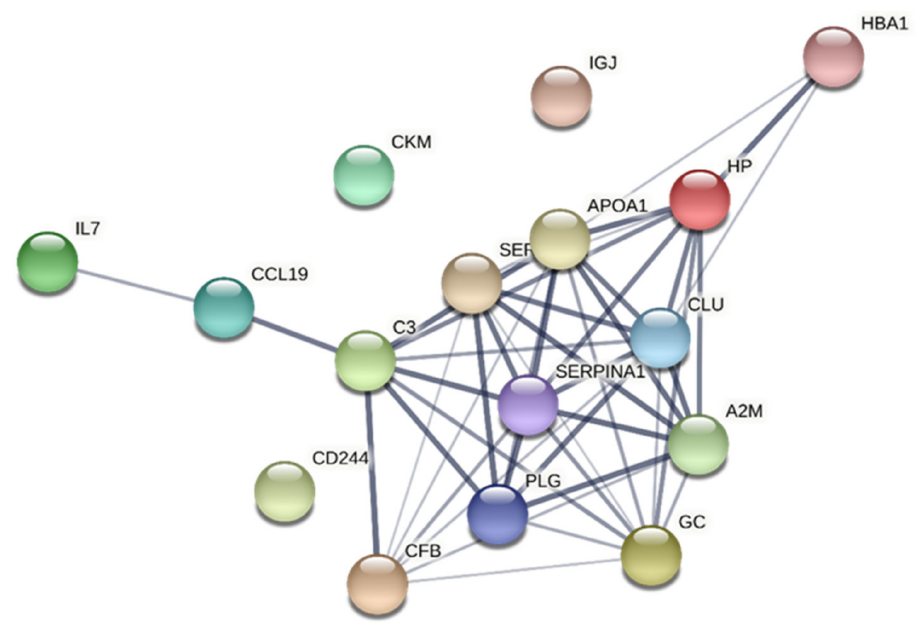
Figure 3. Network analyses of important proteins for CPT in CWP. The network had the following characteristics: number of nodes: 16; number of edges: 45; average node degree: 5.62; avg. local clustering coefficient: 0.636; expected number of edges: 3; PPI enrichment p -value: <1.0 × 10 − 16 . Note that Ig kappa chain C region is not included in STRING. HP = haptoglobin; CFB = complement factor B; GC = vitamin D-binding protein; C3 = complement C3; IL7 = interleukin-7; CKM = creatine kinase M-type; CCL19 = chemokine (C-C motif) ligand 19; CLU = clusterin; PLG = plasminogen; SERPINA1 = alpha-1-antitrypsin; HBA1 = haemoglobin subunit alpha; IGJ = immunoglobulin J chain; SERPINF2 = alpha-2-antiplasmin; APOA1 = apolipoprotein A-I; CD244 = cluster of differentiation 244, natural killer cell receptor 2B4; A2M = alpha-2-macroglobulin; CWP = chronic widespread pain group; CPT = cold pain